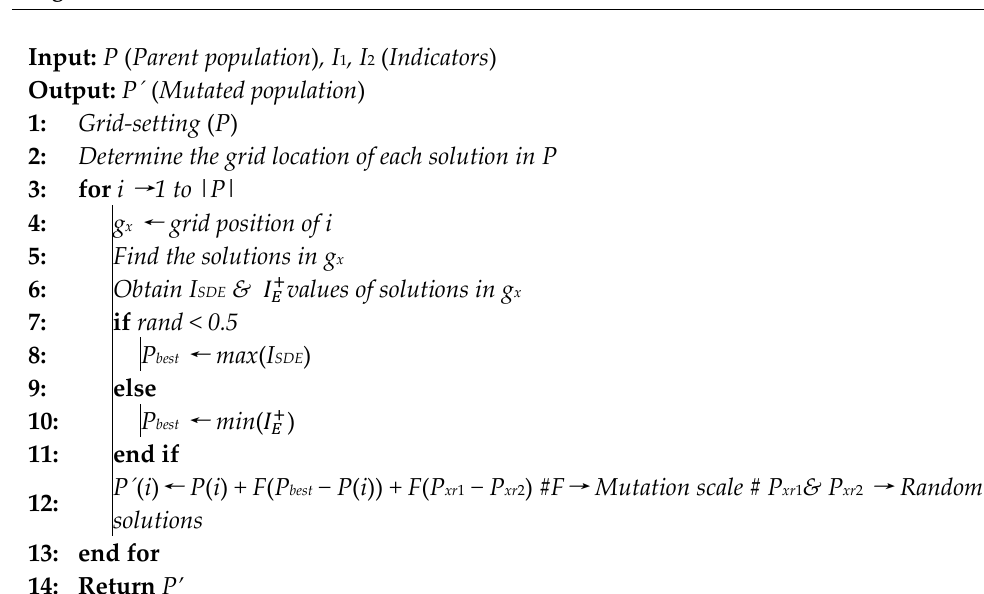
7 of 33 Figure 2. Adaptive grid-based mutation strategy . In Figure 2, 𝑓 (cid:2869) (𝑥) and 𝑓 (cid:2870) (𝑥) are two minimization objectives. The red color denotes the best solution, whereas the black color shows the remaining solutions in each grid. From Figure 2, we can observe that the individuals in the parent population are seg- regated into different grid than the remaining solutions. Thus, the solution will guide the search towards the PF. Similarly, the 𝐼 (cid:3006)(cid:2878) indicator also improves the convergence and